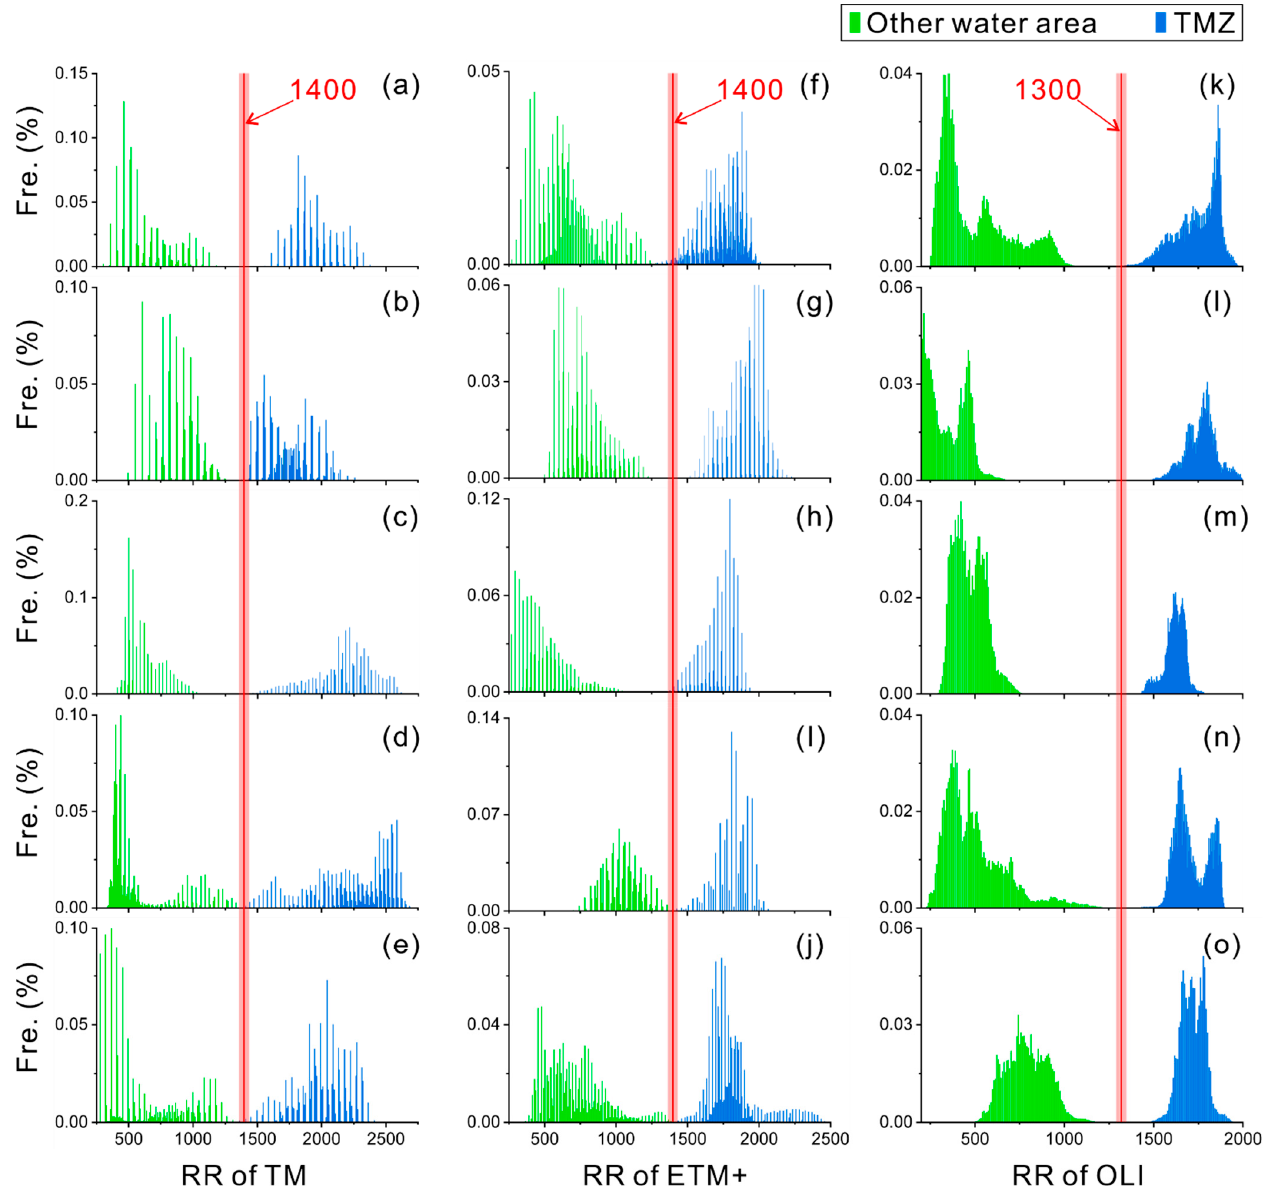
Figure 4. Red band reflectance (RR) frequency (Fre.) histogram of TMZ and other water area in the Yellow River estuary. TMZ and other water area samples in subfigures ( a – e ), ( f – j ) and ( k – o ) were selected based on TM, ETM+ and OLI, respectively. Images ( a - o ) were acquired on 5 February 1989,